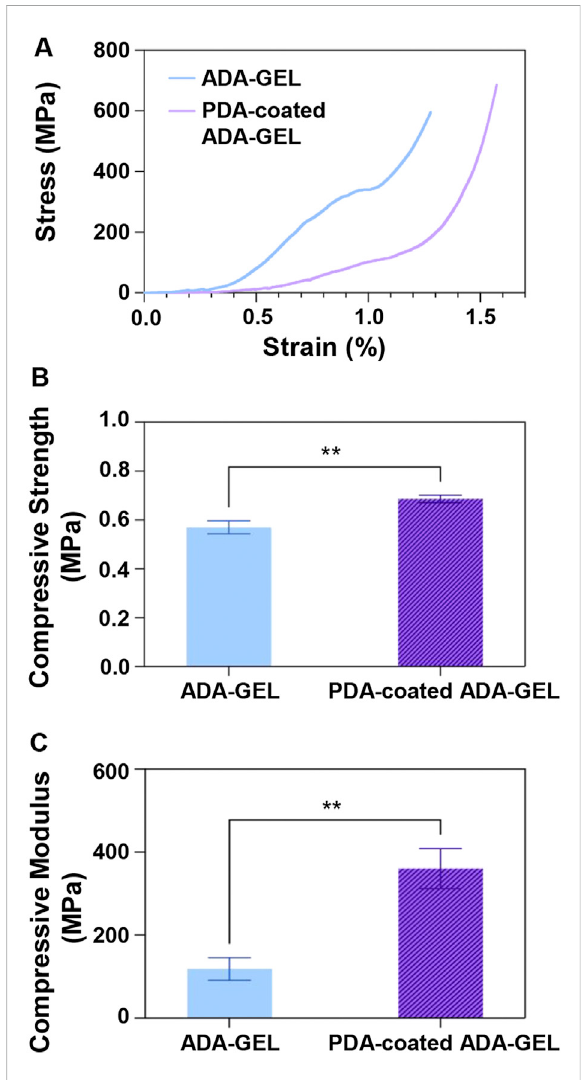
FIGURE 3 Mechanical behavior of the ADA-GEL and PDA-coated ADA- GEL scaffolds. (A) Stress-strain curve, (B) compressive strength, and (C) compressive modulus of scaffolds. Differences are considered very statistically signi fi cant (** p <